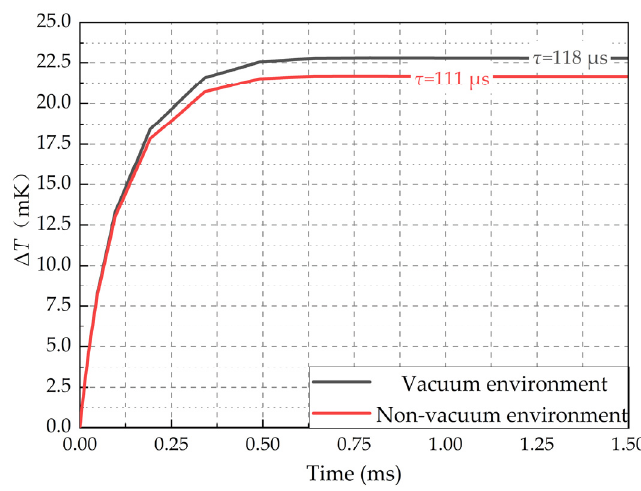
Figure 14. Calculated transient responses of the detectors with vacuum encapsulation and non-vacuum encapsulation. The anchor dimension was set as 5 × 12 μ m.